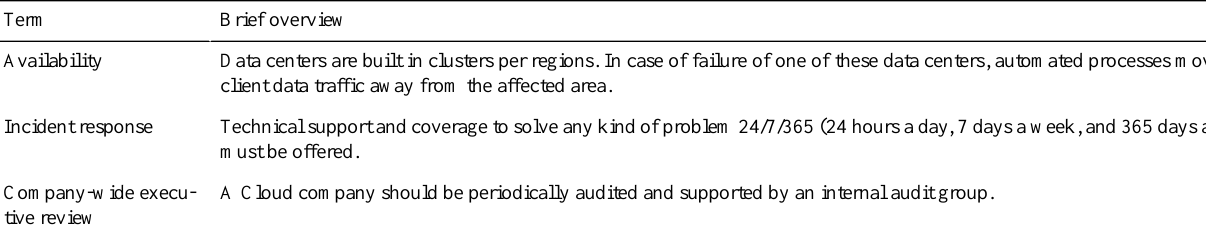
Table 6. Business continuity management. Brief overviewTerm